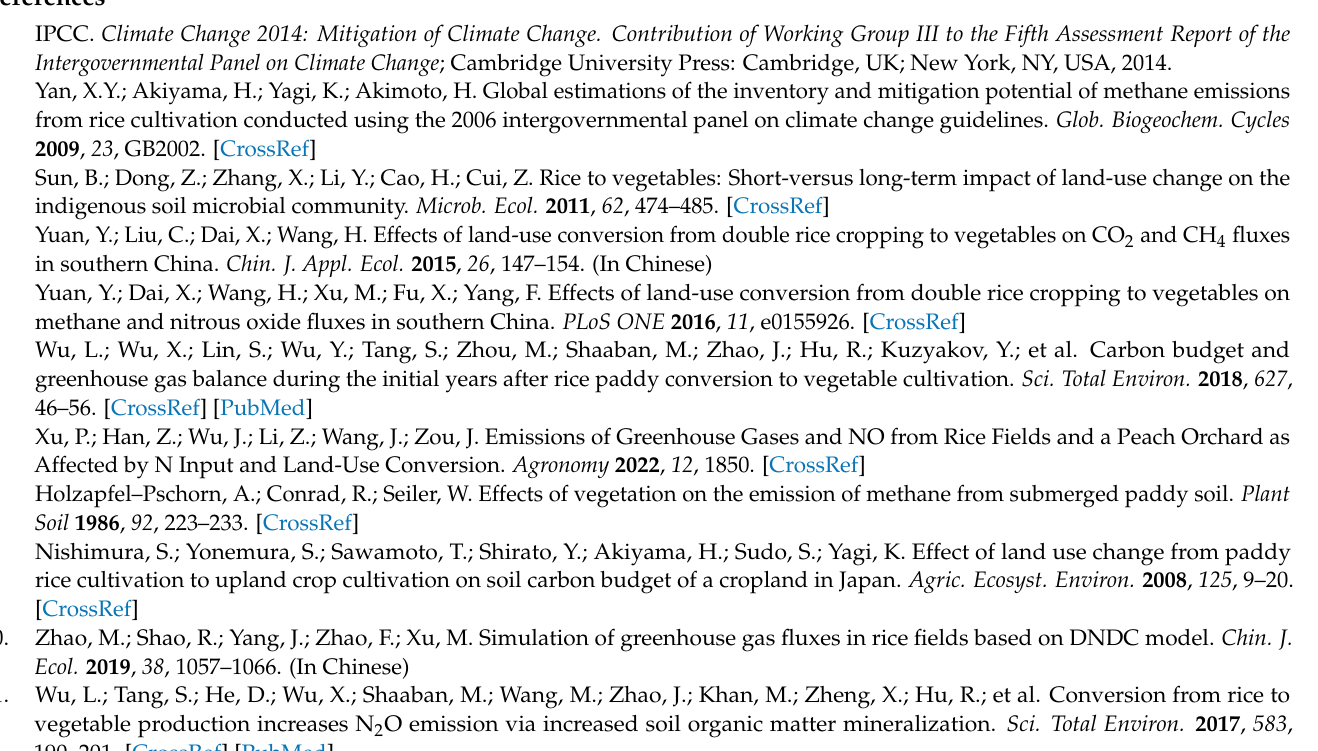
Figure S3. Annual (a) Crop N uptake from soil, (b) N fixation and (c) soil N reductionfrom the 40-year simulations as influenced by cropping systems and fertilizations. R and V represent a rice year or vegetable year, respectively; 0F, 50F, 100F and 150F represent 0%, 50%, 100% and 150% of the conventional fertilization level in the